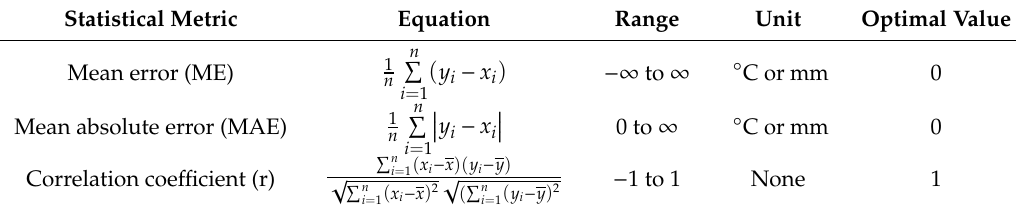
Table 3. Description of the statistical metrics used in the evaluation of environmental data products. Statistical Metric Equation Range